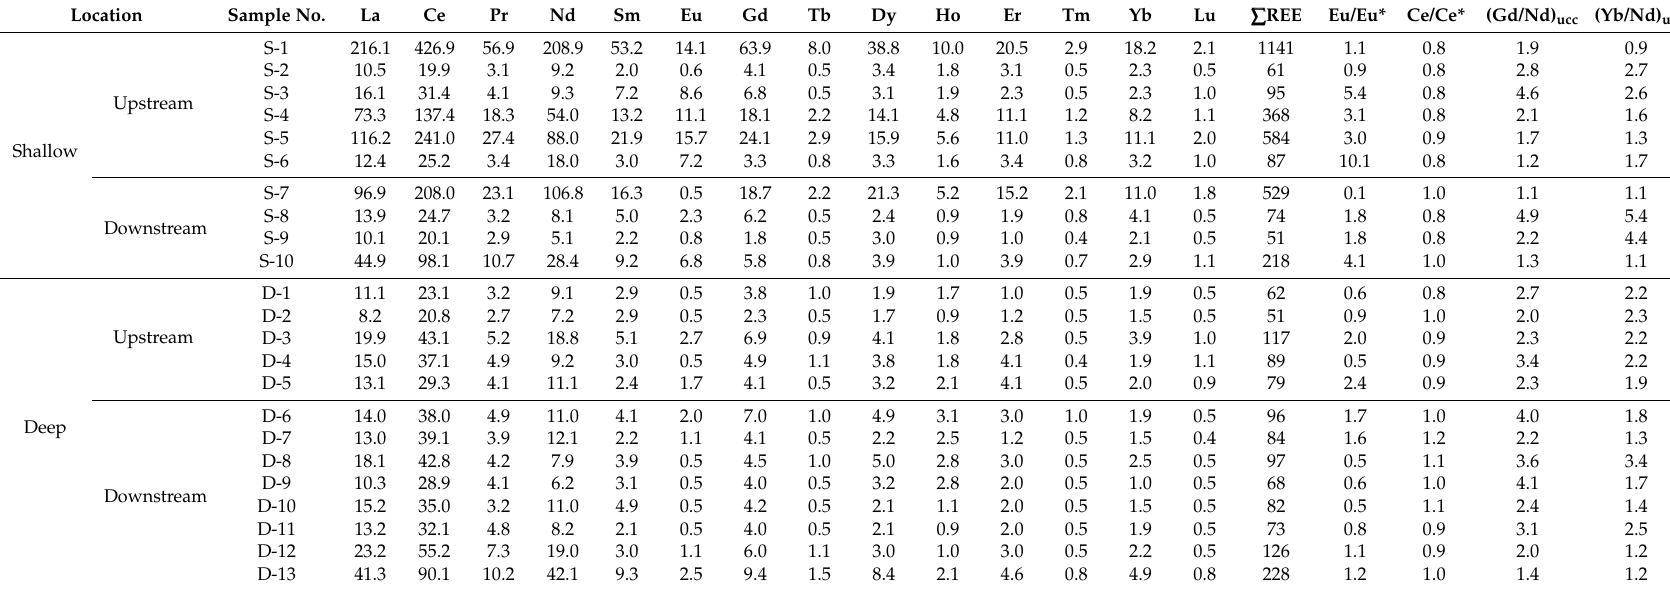
Table A2. REE concentrations (ng/L) and fractionation parameters (Eu/Eu*, Ce/Ce*, (Gd/Nd) UCC , (Yb/Nd) UCC ) of groundwater samples. Location Sample No. La